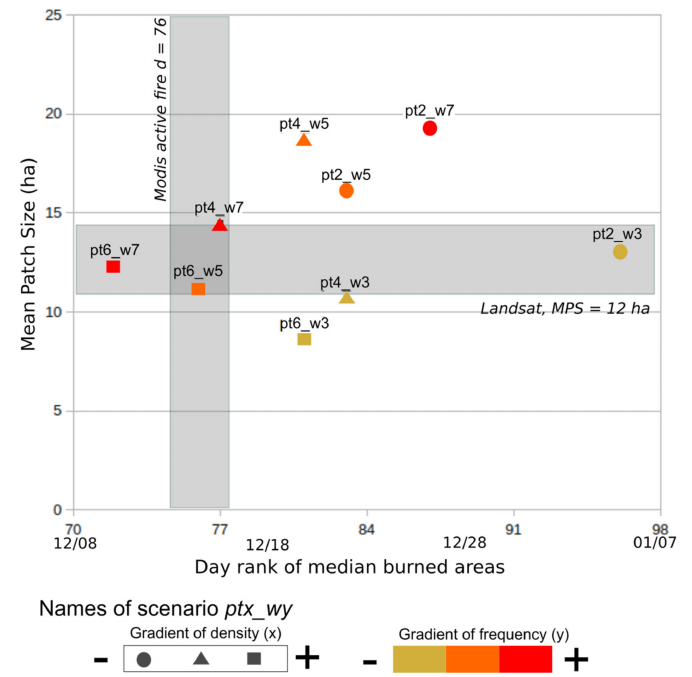
Figure 6. Fire regimes simulated localized by their spatial and temporal